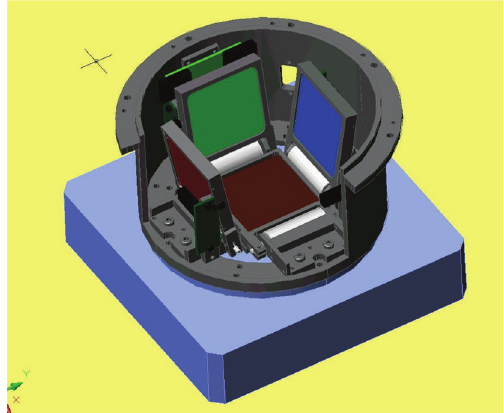
Figure 4: Photometer with 3 filters and 1 polarimeter based on an Apogee AltaU16M CCD